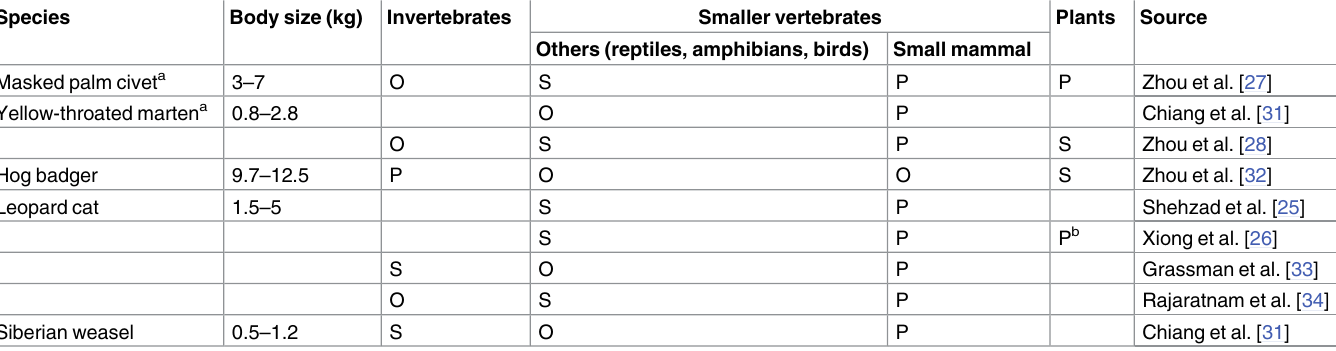
Table 1. Body size and diet of the five common mesocarnivores according to studies from China and Southeast Asia. Data of body sizes are from Smith et al. [30]. Relative importance of food sources was classified into three categories: P, primary; S, secondary; and O, occasional. Species